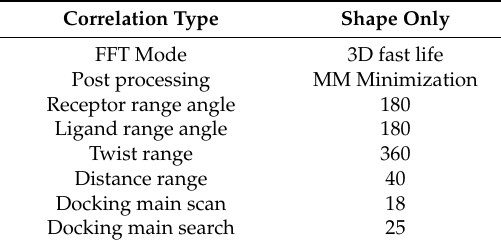
Table 3. Hex parameters used in this